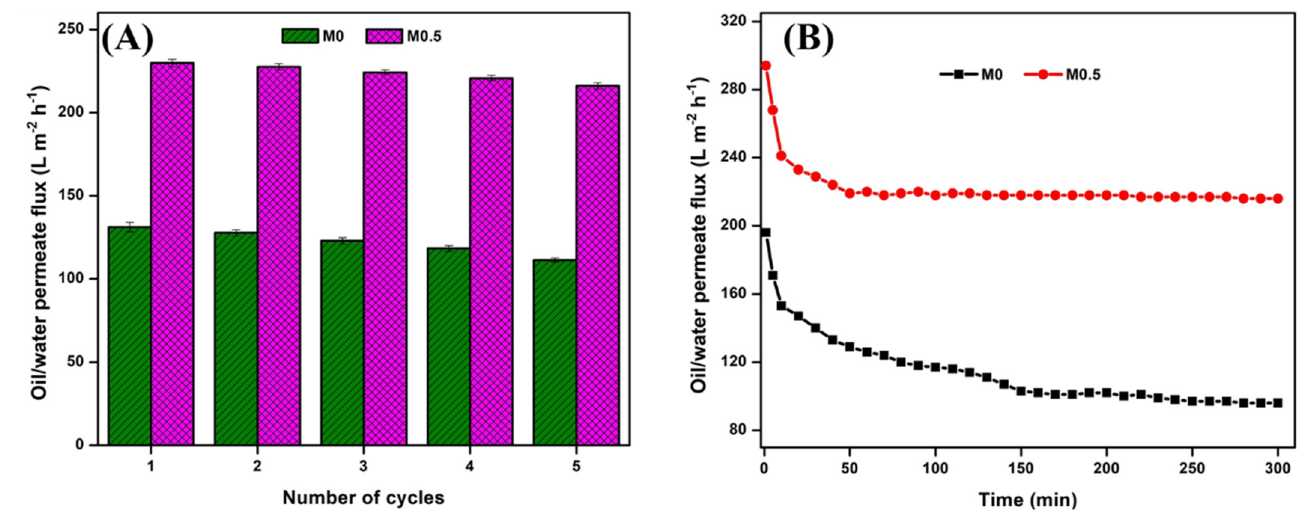
Figure 8. ( A ) Cyclic stability and ( B ) Long-term o/w filtration performance of M0 (control) and M0.5 membranes.